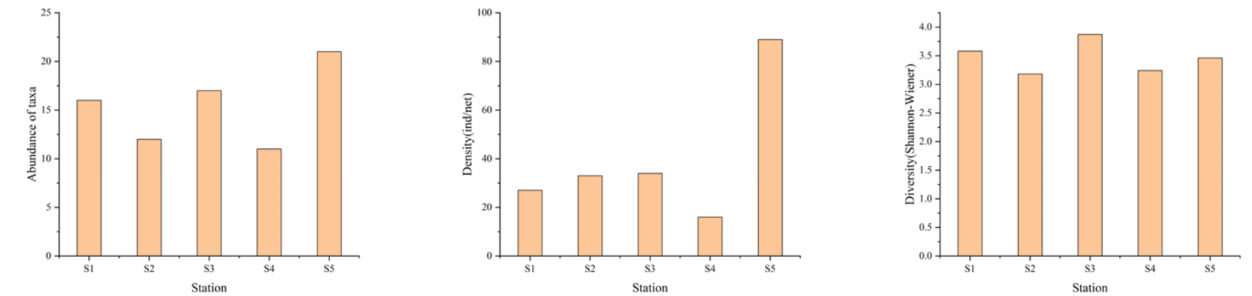
Figure 7. The abundance of taxa, individual density of benthos, and diversity for the benthic fauna (Shannon–Wiener